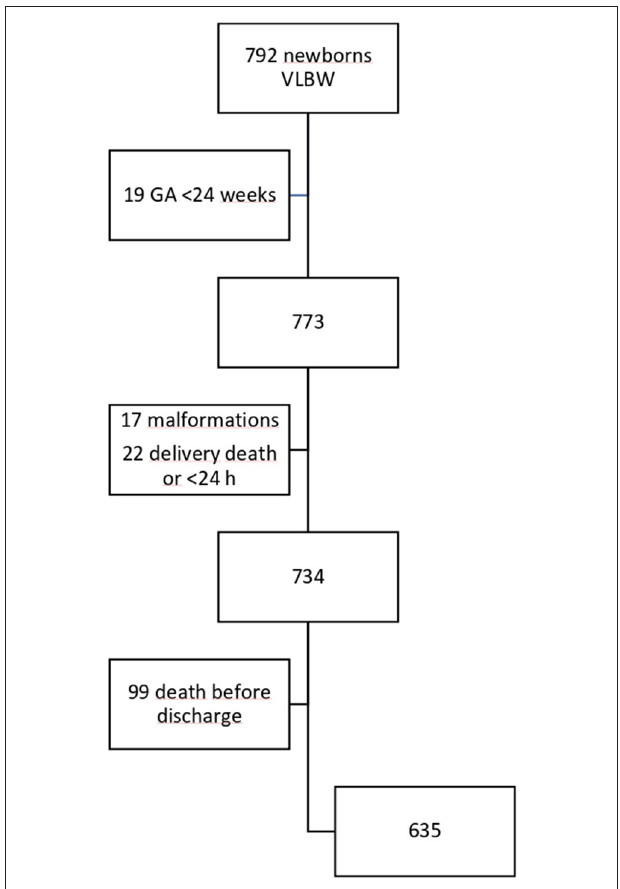
FIGURE 1 | Flowchart of the sample according to inclusion criteria and study population. VLBW, Very low birth weight.